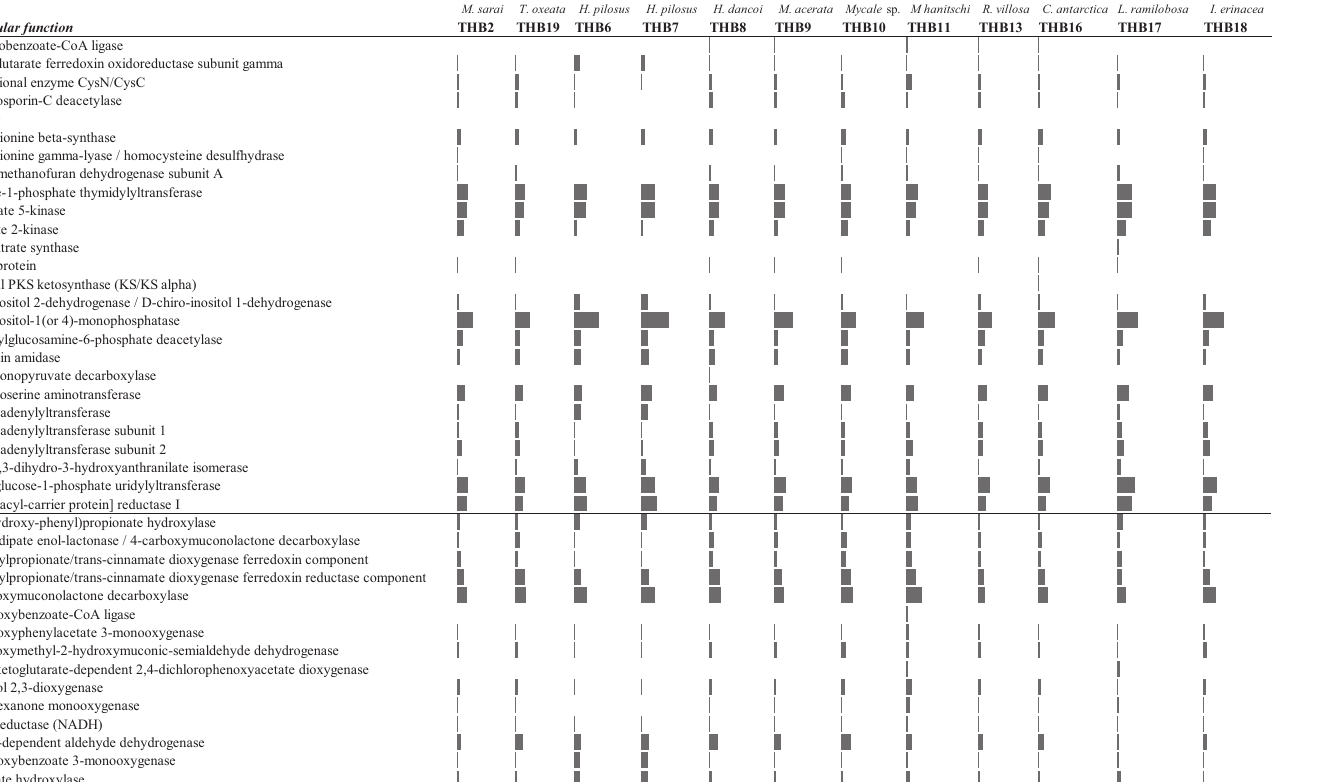
TABLE 4 | KEGG pathway stored by biological process and molecular function with relative predicted enrichment value in all